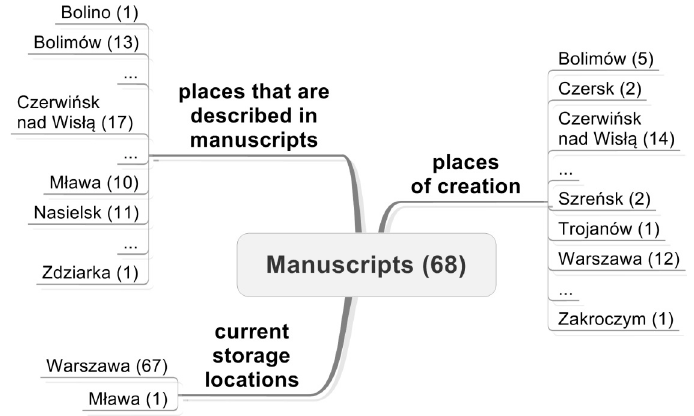
Figure 3. Spatial references of the manuscripts (source: own work based on the digital collection “Cities in archival documents”).